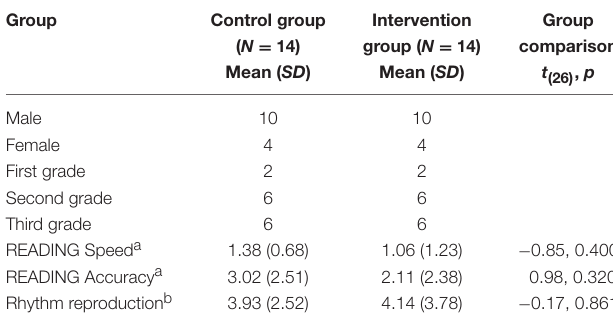
TABLE 1 | Participants’